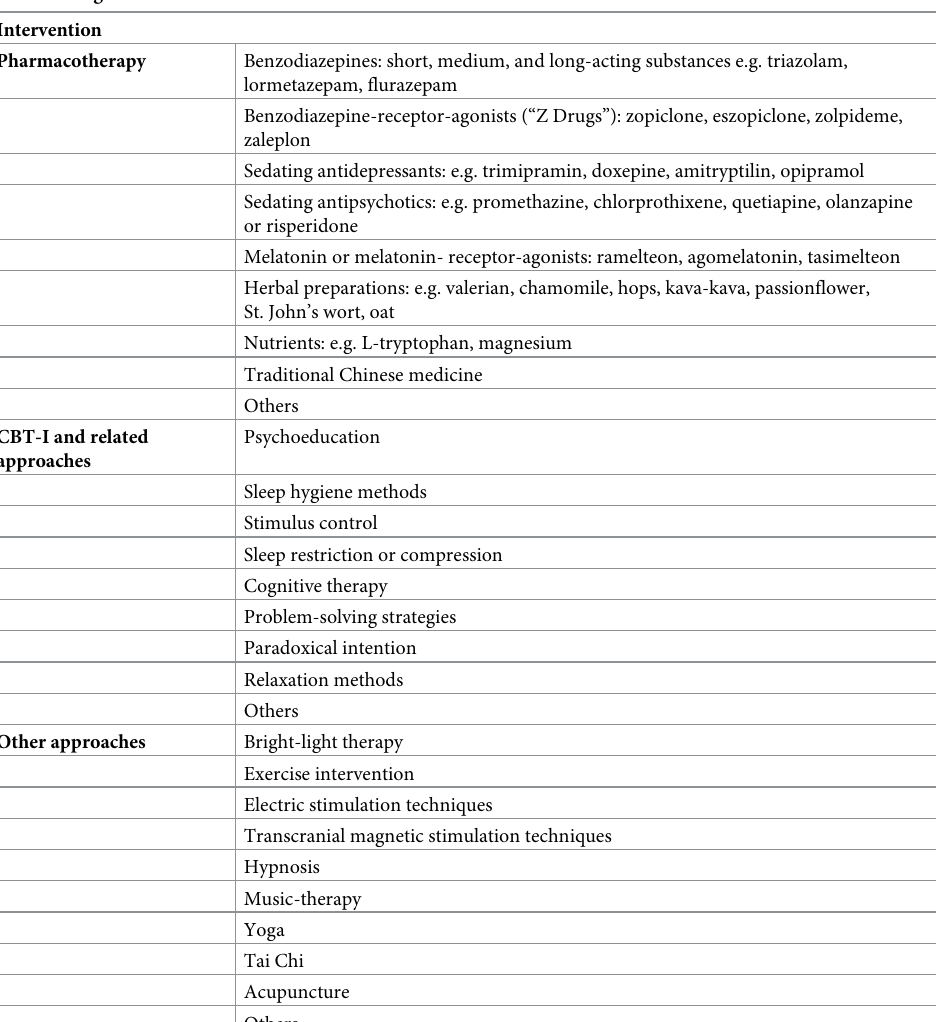
Table 1. Eligible